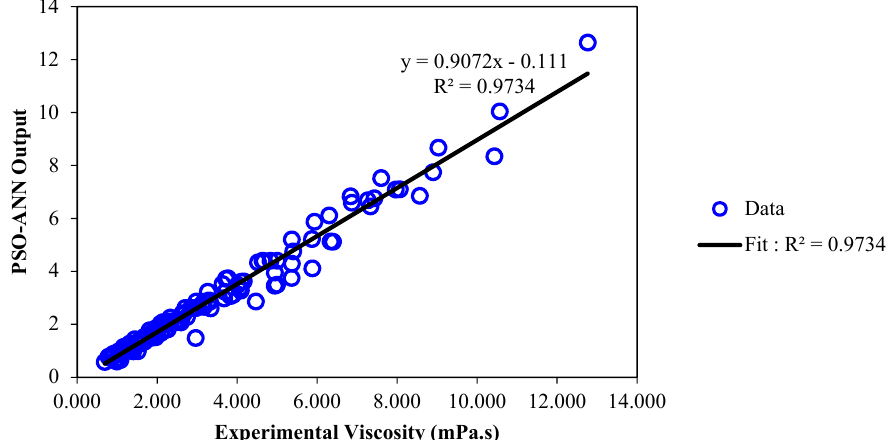
y = 0.9072x - 0.111 R² = 0.9734